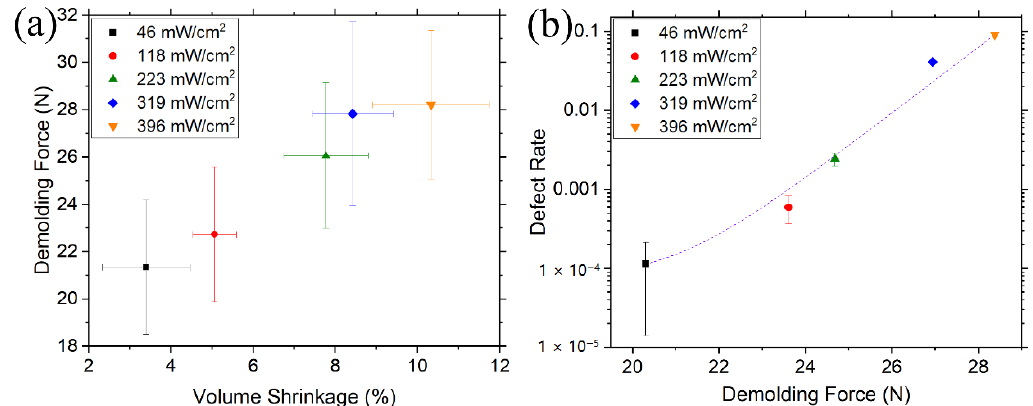
Figure 12. ( a ) Correlation between polymerization volume shrinkage and measured demolding force of the UV-curable resist when exposed to 365-nm UV radiation at various intensities for 15 s. ( b ) The correlation between the demolding force and the resultant defect rate for the resists cured under different UV exposures. Reprinted with permission from